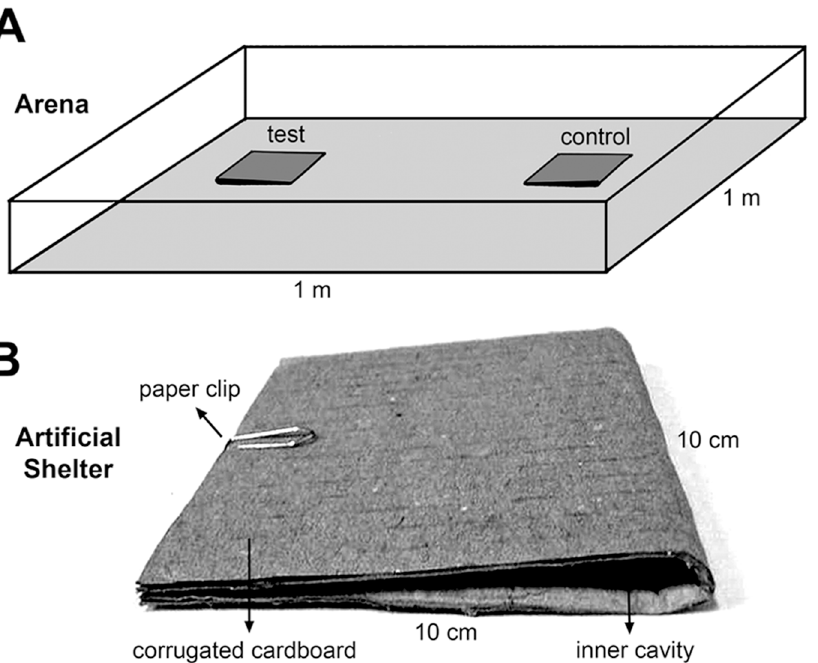
Figure 1. Schematic drawing showing: A- the experimental arena used in the shelter assays and, B- a picture of an artificial refuge.